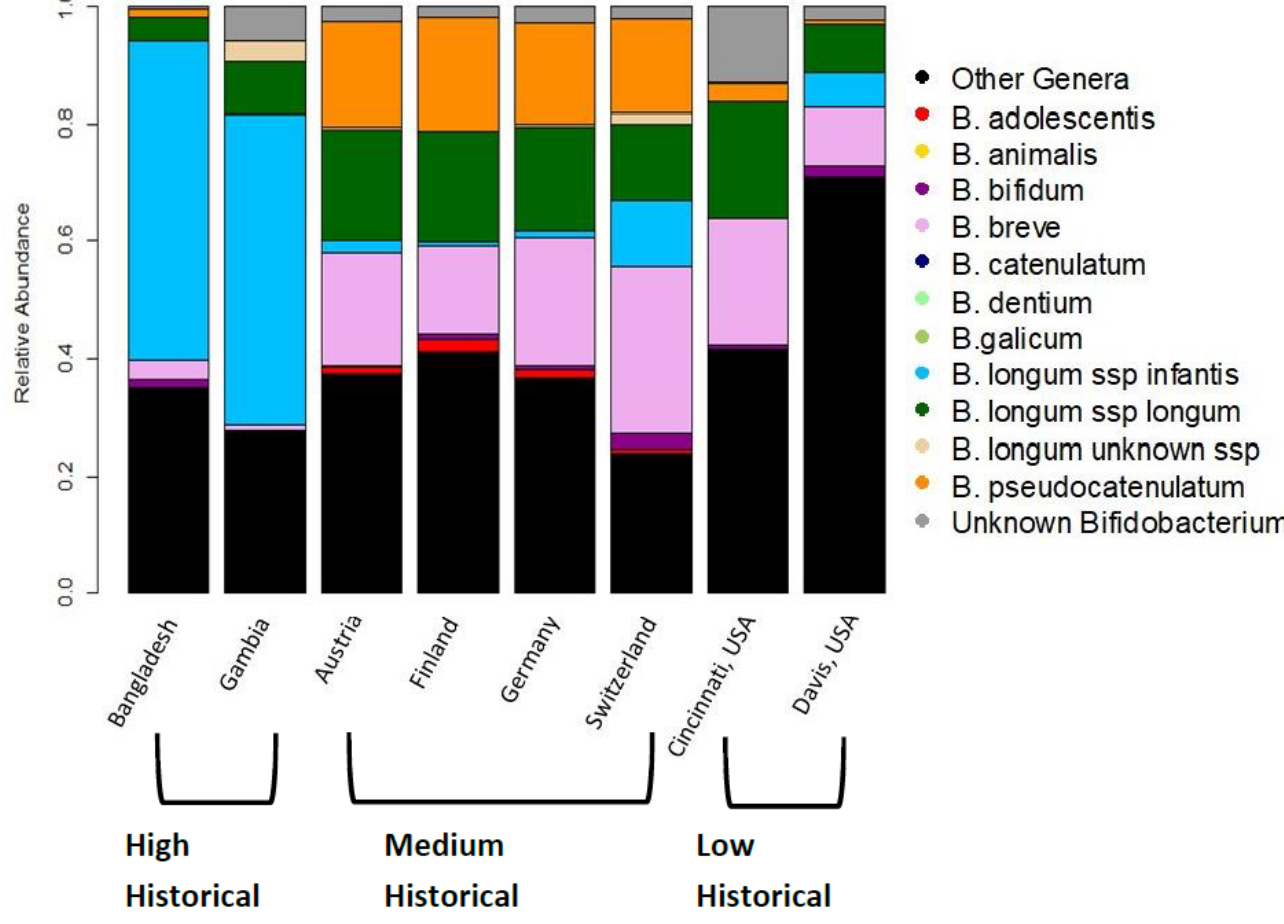
Figure 1. Average gut microbiome colonization patterns by country.